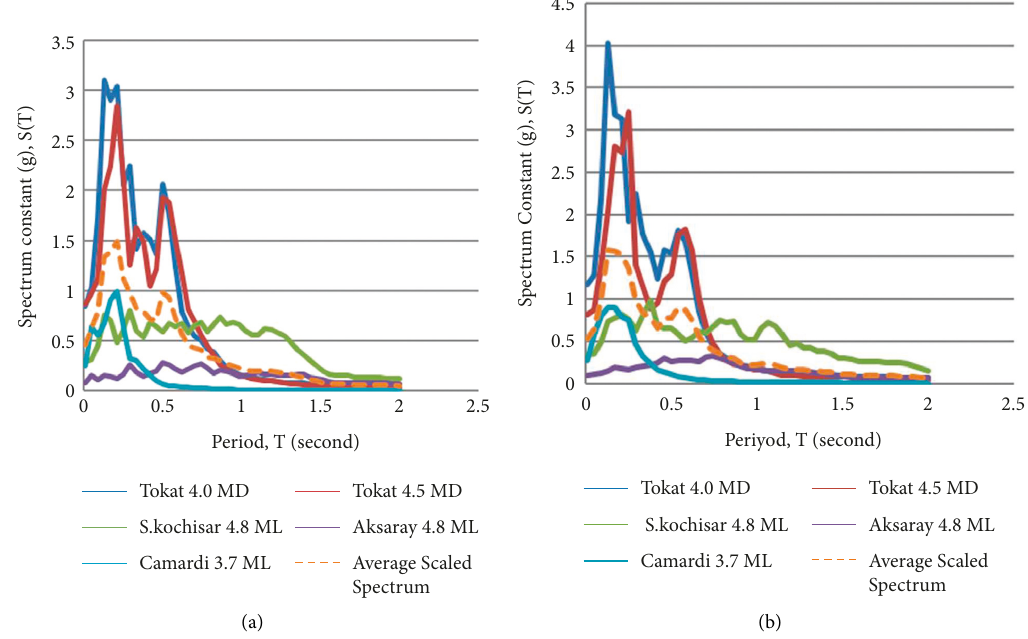
Figure 7: Response spectra of earthquake records scaled according to elastic design acceleration spectrum (with local site class Z3); (a) North-South (N-S) and (b) East-West (E-W)